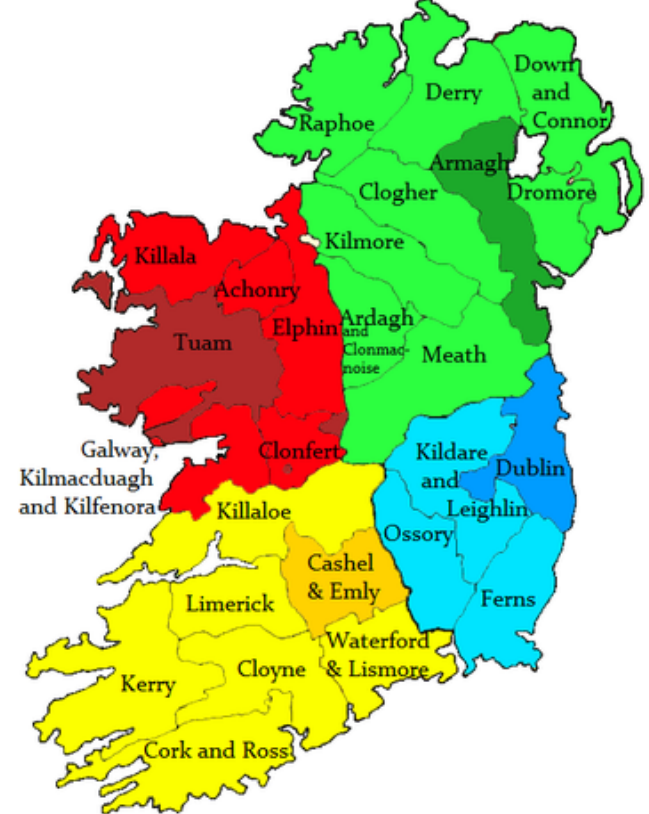
Figure 1. Map of the 26 Catholic dioceses in Ireland. Figure 2. Map of the 26 Catholic dioceses in